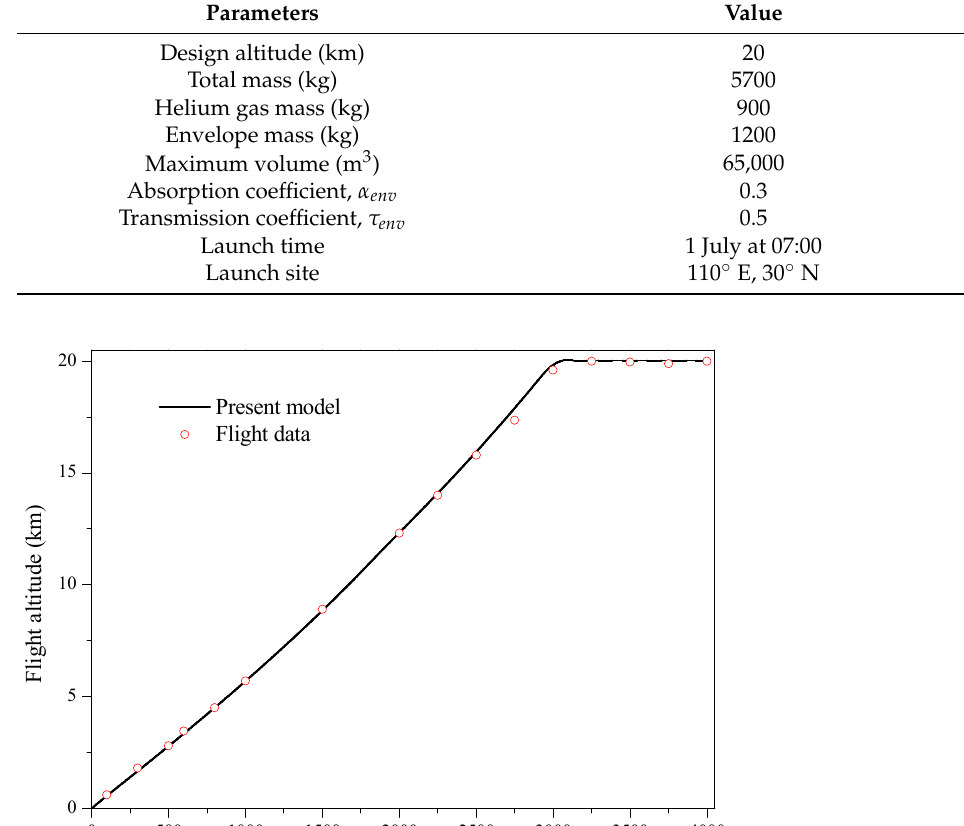
Table 1. Design parameters of the near-space aerostat used for comparison [33].